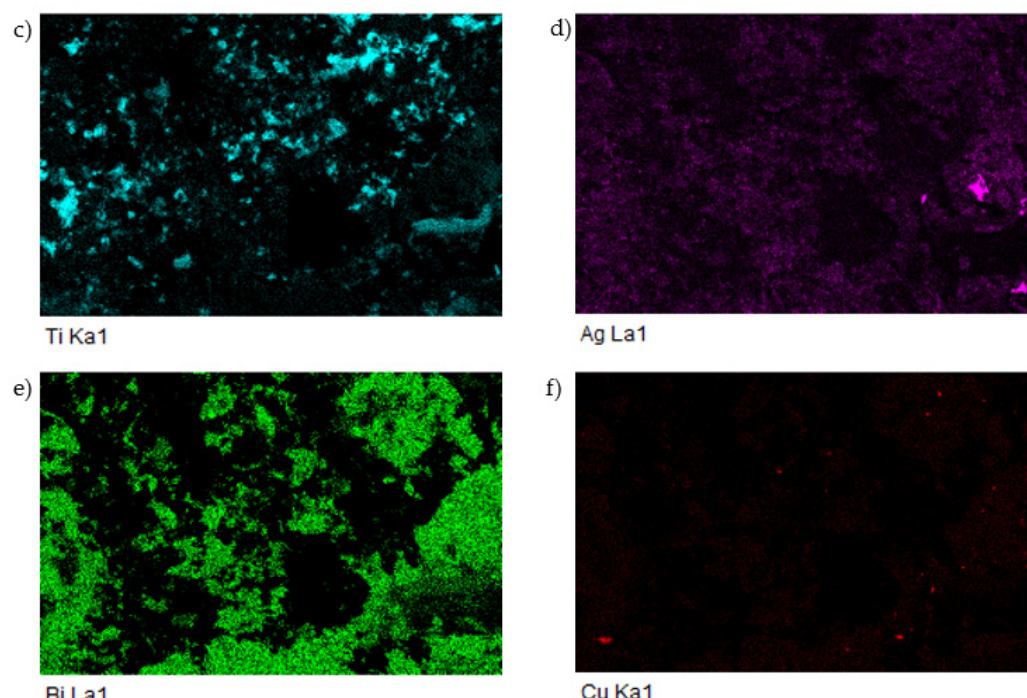
Figure 24. Fractured surface of soldered joint of Si/BiAg11Ti1,5/Cu and the planar distribution of elements ( a ) fracture structure; ( b ) Si; ( c ) Ti; ( d ) Ag; ( e ) Bi; ( f ) Cu.